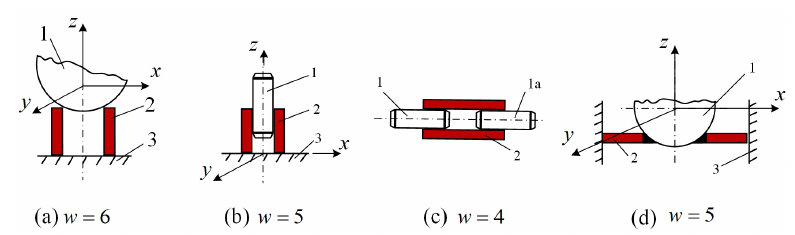
Figure 1. General schematics of the piezoelectric actuator with two active kinematic pairs.